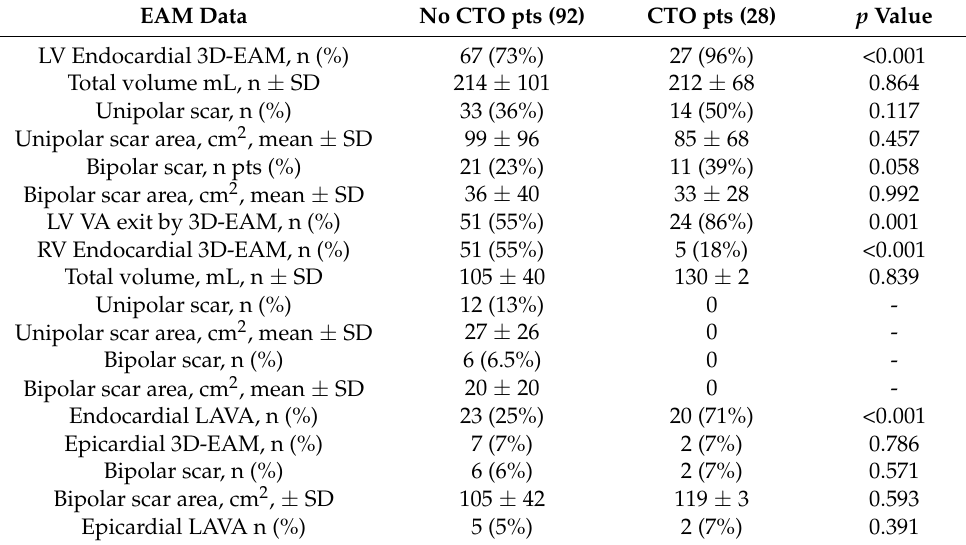
Table legend: CTO: Coronary total occlusion; 3D-EAM: three-dimension electroanatomic mapping; LAVA: local abnormal ventricular activities; LV left ventricular; VA ventricular arrhythmias.